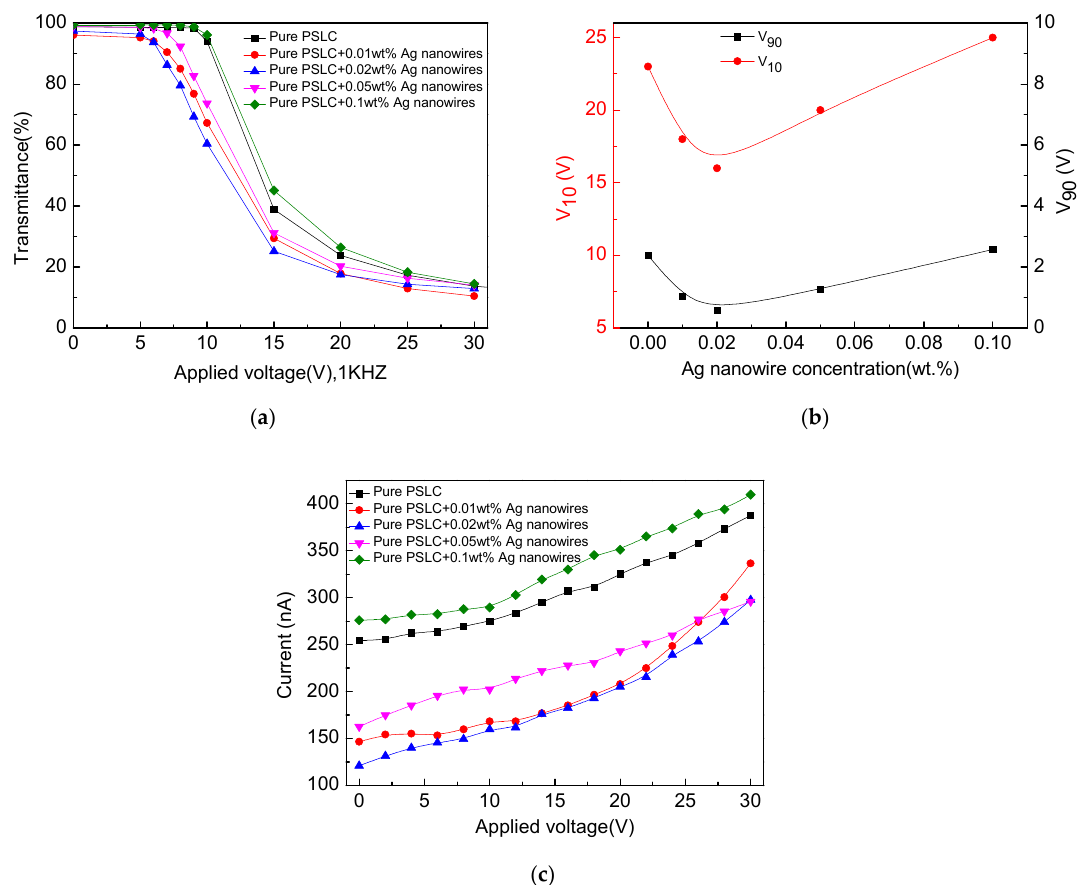
Figure 5. Voltage–Transmittance (V–T) curves, threshold voltages and leakage current of the Ag nanowire doped PSLC according to the Ag nanowire concentration: ( a ) V–T curve; ( b ) variations in voltages for 10% transmission (V 10 ) and voltages for 90% transmission (V 90 ); and ( c ) leakage current according to the Ag nanowire concentration.